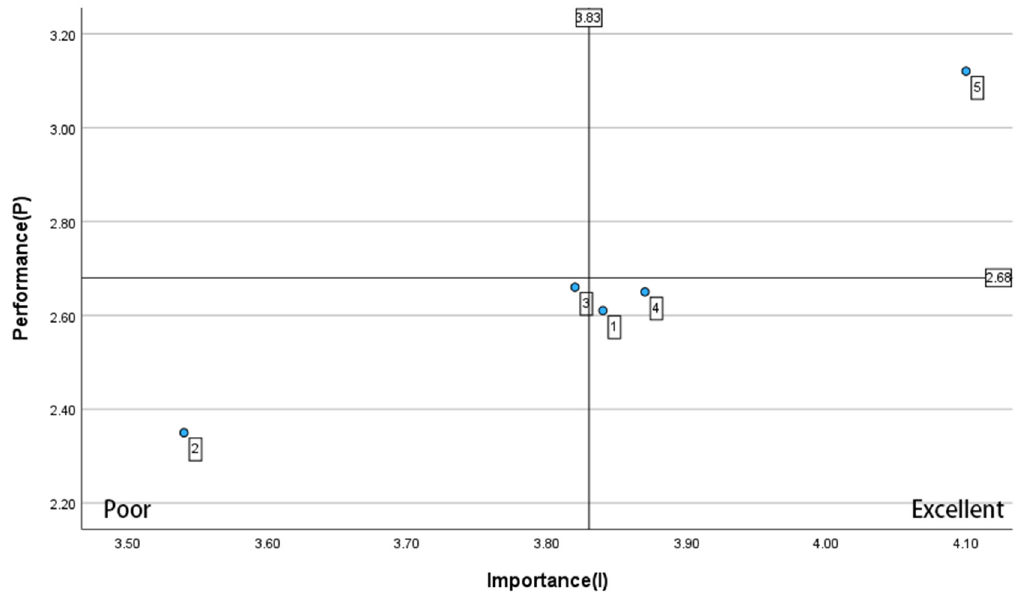
Figure 2. IPA matrix of items at the first level of classification. Note: 1. Official website function; 2. Tokyo Zoonet function; 3. Smart (Tokyo Parks Navi) phone application(s); 4. Smart phone website application(s) (Tokyo Zoovie); 5. Functions within the zoo.